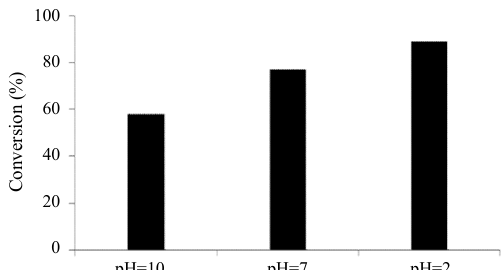
Fig. 10. The effect of acidic, natural and basic media on the conversion of NB (%) (catalyst: 0.1 g, NB: 0.0136 M, irradiation time: 120 min)